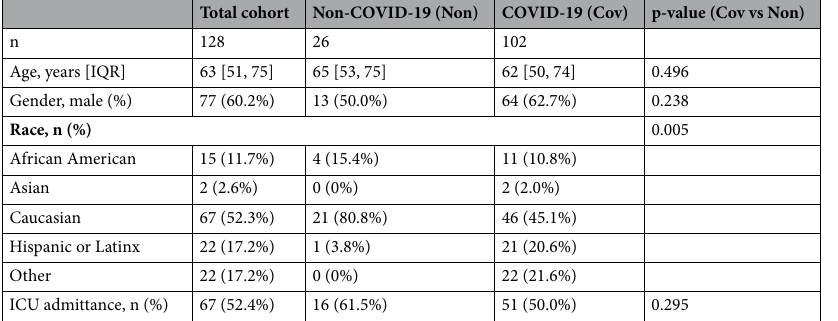
CpG site M-values were examined with UMAP (Fig. 1C) clustering can be observed. The predictive power of our model was assessed by contrasting the cross-validated predicted probability of belonging to a specific class